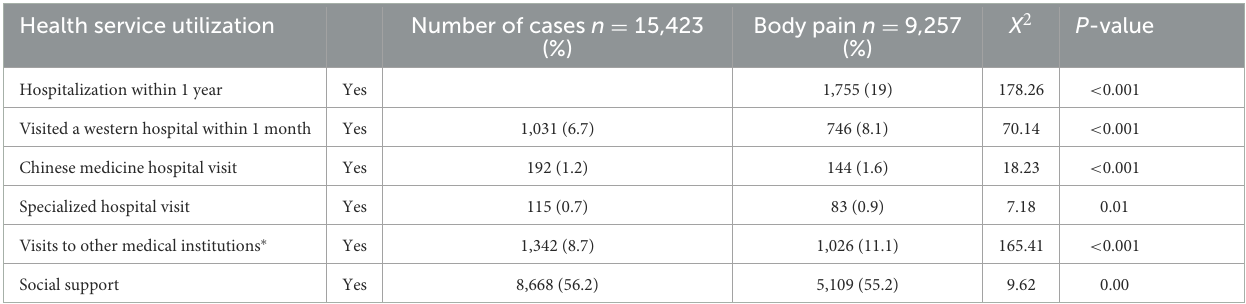
TABLE 3 The relationship between physical pain and health service